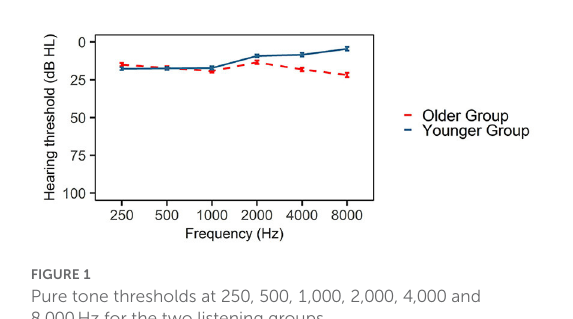
FIGURE1 Pure tone thresholds at 250, 500, 1,000, 2,000, 4,000 and 8,000Hz for the two listening groups.